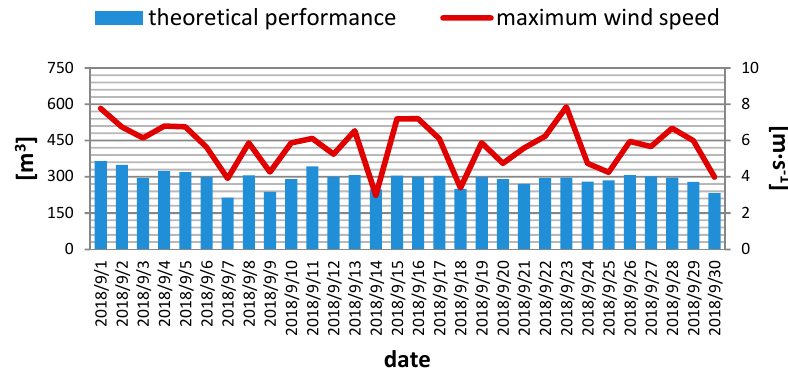
Figure 10. Efficiency of the pulverization unit of the aerator in September.